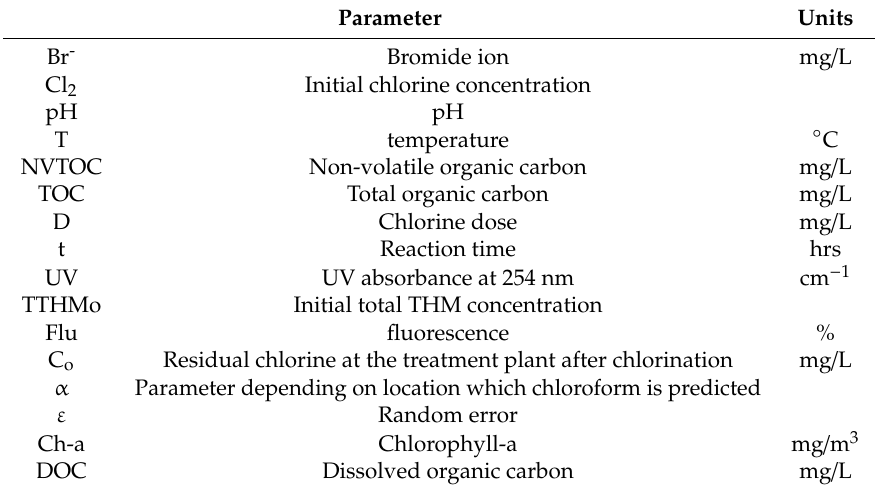
Table 1. Disinfection-by-products (DBPs) predictive models’ parameters (based on